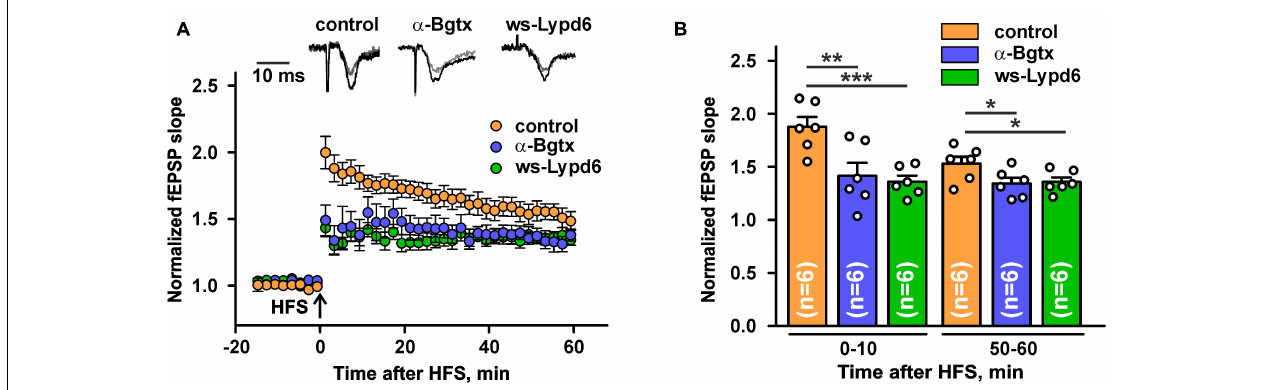
FIGURE 6 | Ws-Lypd6 suppresses long-term potentiation (LTP) in the mice hippocampal slices. (A) Averaged 1 h LTP responses in hippocampal slices after 1 h preincubation in ACSF containing 1 µ M ws-Lypd6 or 10 nM α -Bgtx (in each case n = 6 slices, six mice). The same compounds were present in ACSF during recording. Representative normalized fEPSP traces are shown above: gray—baseline, black—post-tetanic recording. (B) Normalized fEPSP slopes averaged over 0–10 and 50–60 min after HFS. The data are presented as mean ± SEM. * ( p < 0.05), ** ( p < 0.01), and *** ( p < 0.001) indicate significant difference ( t- test).